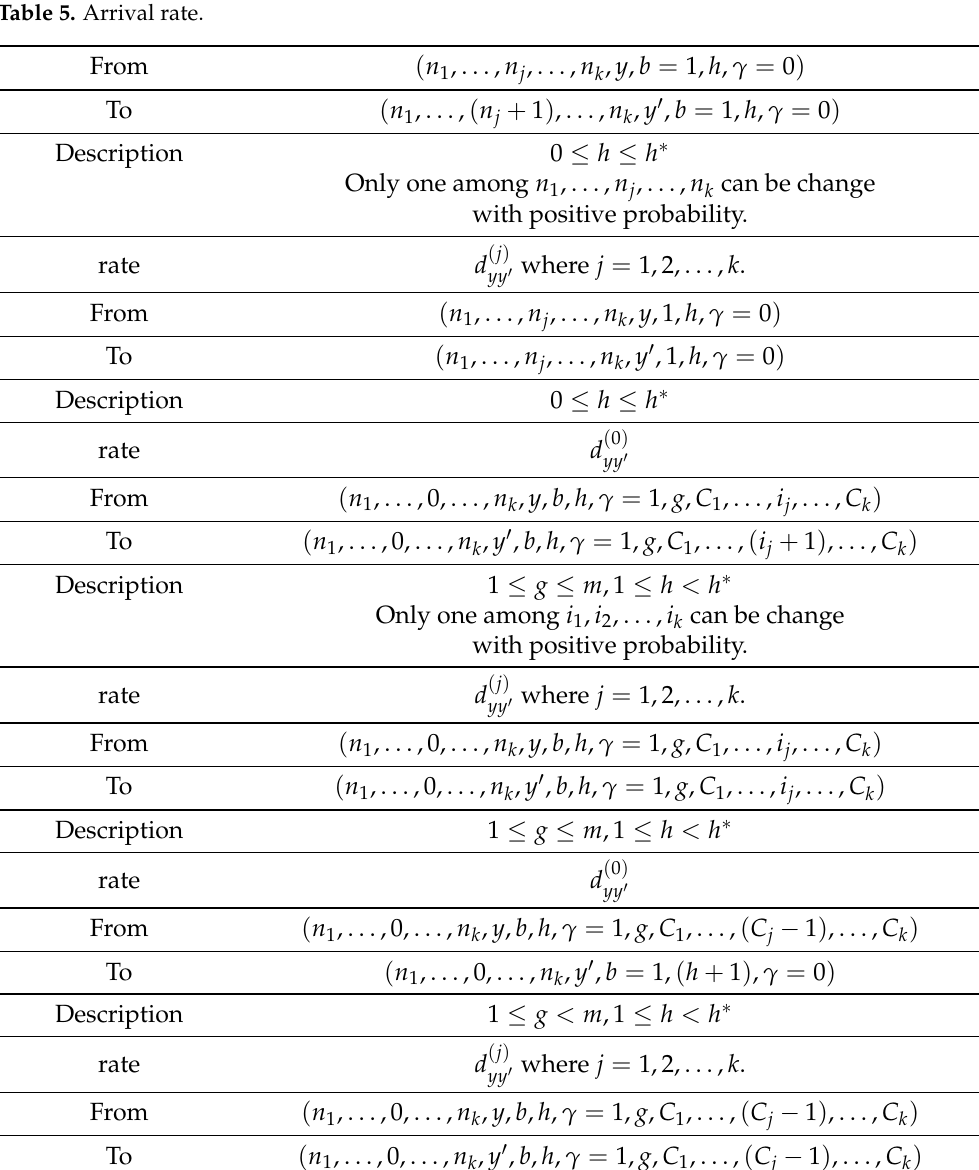
Table 5. Arrival